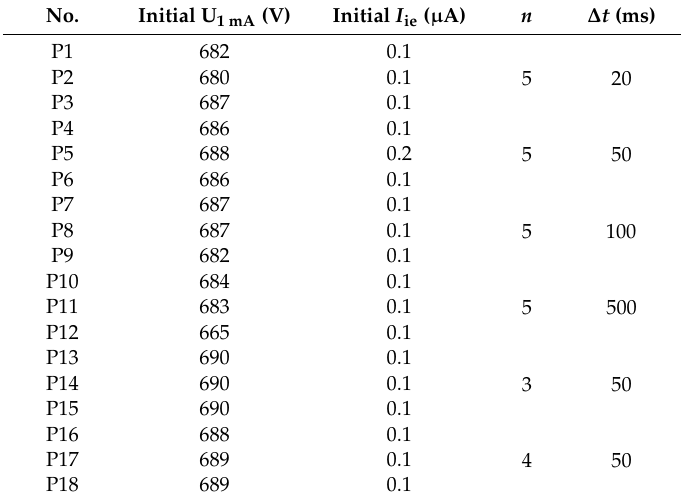
Table 2. The static parameters of different samples and the corresponding impulse current waveform parameters.